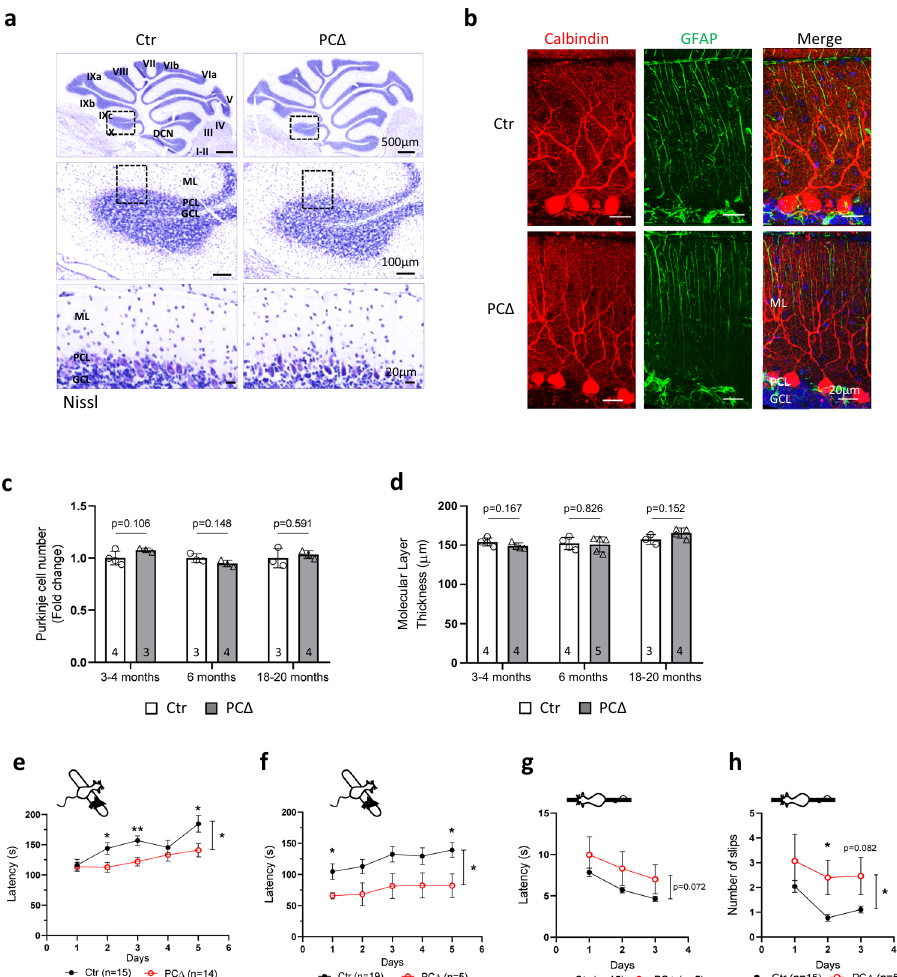
Fig. 1 Deletion of ATR in Purkinje cells leads to locomotor dysfunction and learning defects in mice. a Sagittal brain sections of the control (Ctr) and ATR-PC Δ (PC Δ ) brains were stained with cresyl violet (Nissl staining). Upper panel shows the complete cerebellum. The magni fi ed view of the frames in the upper and mid panels are shown in the lower panels, respectively. The images are representative from 3 to 4 mice of each genotype analyzed. DCN Deep Cerebellar Nuclei, ML Molecular Layer, PCL Purkinje Cell Layer, GCL Granular Cell Layer. b Sagittal sections of 3-month-old control and ATR-PC Δ mice were stained with DAPI, Calbindin and GFAP antibodies to label nuclei, Purkinje cells and Bergmann glia, respectively. ML Molecular Layer, PCL Purkinje Cell Layer, GCL Granular Cell Layer. c Quanti fi cation of total Purkinje cell number compared to control at the indicated age. The data is represented as fold changes compared to the control group. The number of mice is indicated within the bar. Error bars indicate SD. Student ’ s t -test (unpaired, two- tailed) is performed for the statistical analysis. The p values are indicated in the graphs. d Quanti fi cation of the thickness of the molecular layer of the cerebellum of mice at the indicated age. The number of mice is indicated within the bar. Student ’ s t -test (unpaired, two-tailed) is performed for the statistical analysis. The p values are indicated in the graphs. e The rotarod performance of 4 – 9-month-old mice on fi ve consecutive days. Error bars indicate SEM. P values: day 2, p = 0.014; day 3, p = 0.002; day 5, p = 0.028; group comparison p = 0.034. f The rotarod performance of 18 – 20-month-old mice on fi ve consecutive days. Error bars indicate SEM. P values: day 1 p = 0.025; day 5, p = 0.024, group comparison p = 0.041. g The beam walking performance was tested in the 18 – 20-month-old group. The latencies on 1 cm width beam platform on three consecutive days are shown. Error bars indicate SEM. p = 0.072. h The number of hindlimb slips during the beam walking performance test. Error bars indicate SEM. P values: day 2, p = 0.015; group comparison, p = 0.017. Two-way repeated measures ANOVA with Sidak ’ s multiple comparisons test or MWU within individual days was performed for the statistical analysis in e – h . * p < 0.05, ** p < 0.01. The number of mice ( n ) tested are indicated within the graph legend. Source data are provided as a Source Data fi